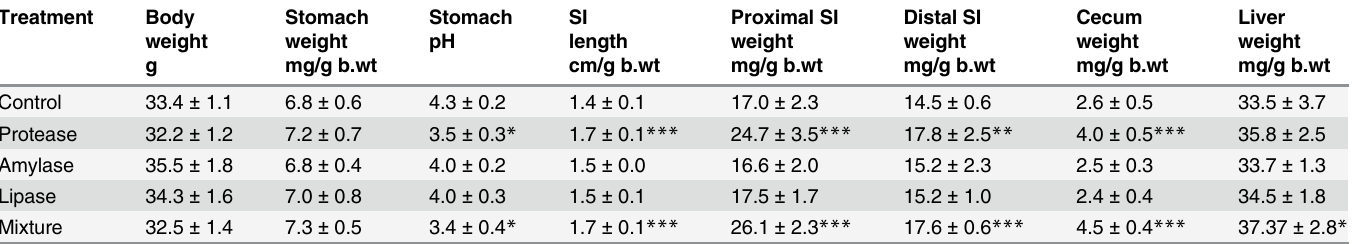
Table 2. Body weight, gut organ growth and stomach pH of 17 d-old rats after gavage feeding with microbial-derived enzymes, i . e ., a protease, amylase, lipase, and a mixture thereof, or water (control) during 14 – 16 days of age. Treatment